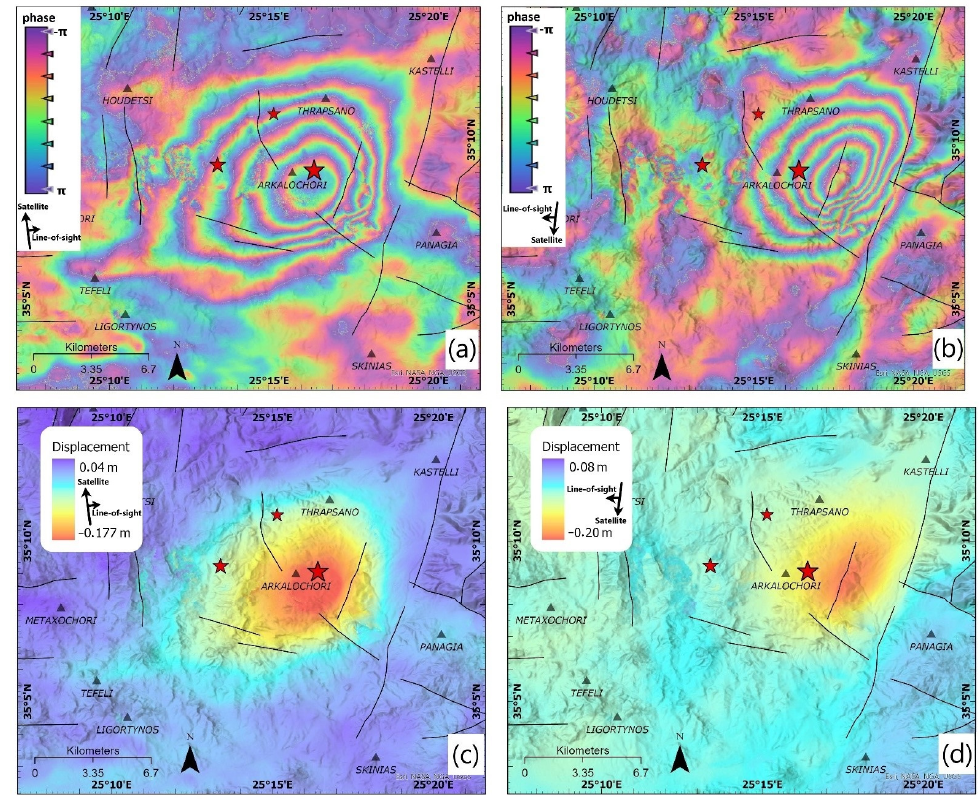
Figure 6. ( a , b ). Wrapped ascending (image pair 23 September–29 September 2021(track 102)) and descending (image pair 25 September–1 October 2021 (track 36)) co-seismic interferograms over the Arkalochori area; ( c , d ) LoS displacement maps in the ascending and descending orbit. The epicenters of the main event and of the two major aftershocks are shown with red stars.